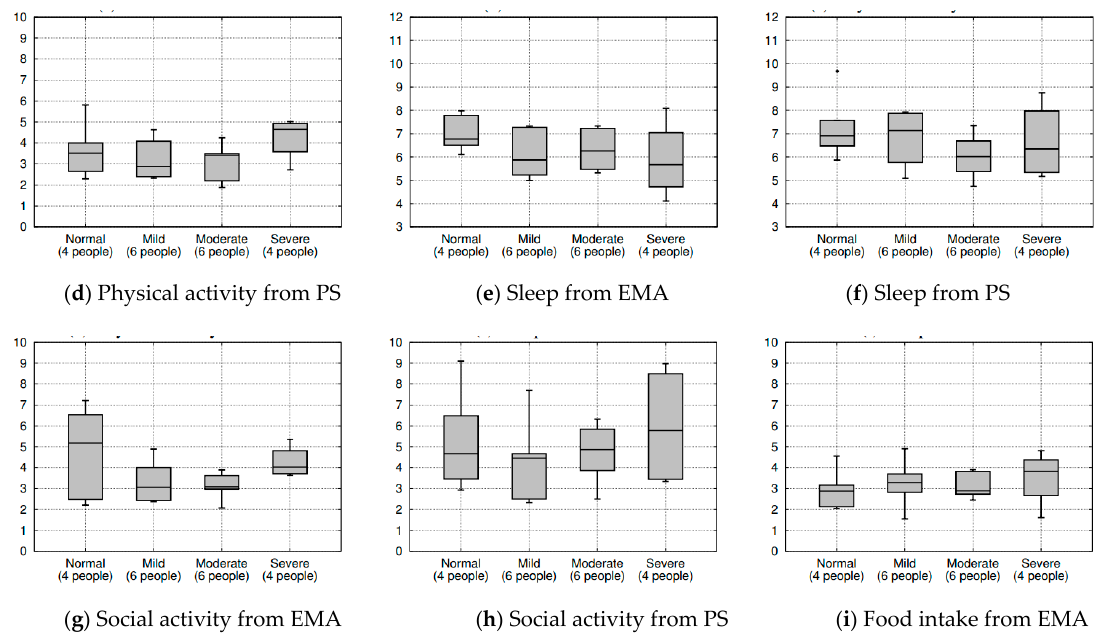
Figure 11. Box plots of EMA and passive sensing on five elements as a function of four participant groups: ( a )–( b ) mood; ( c )–( d ) physical activity; ( e )–( f ) sleep; ( g )–( h ) social activity; ( i ) food intake.